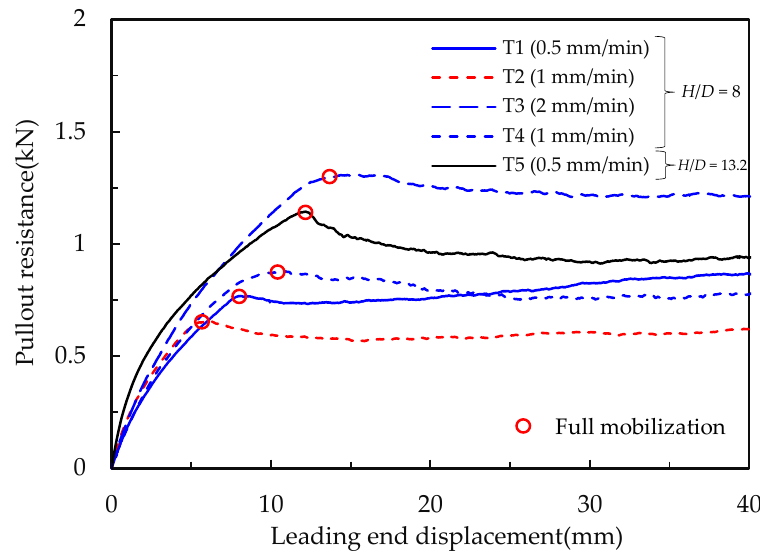
Figure 3. Axial pullout resistance with leading end displacement.